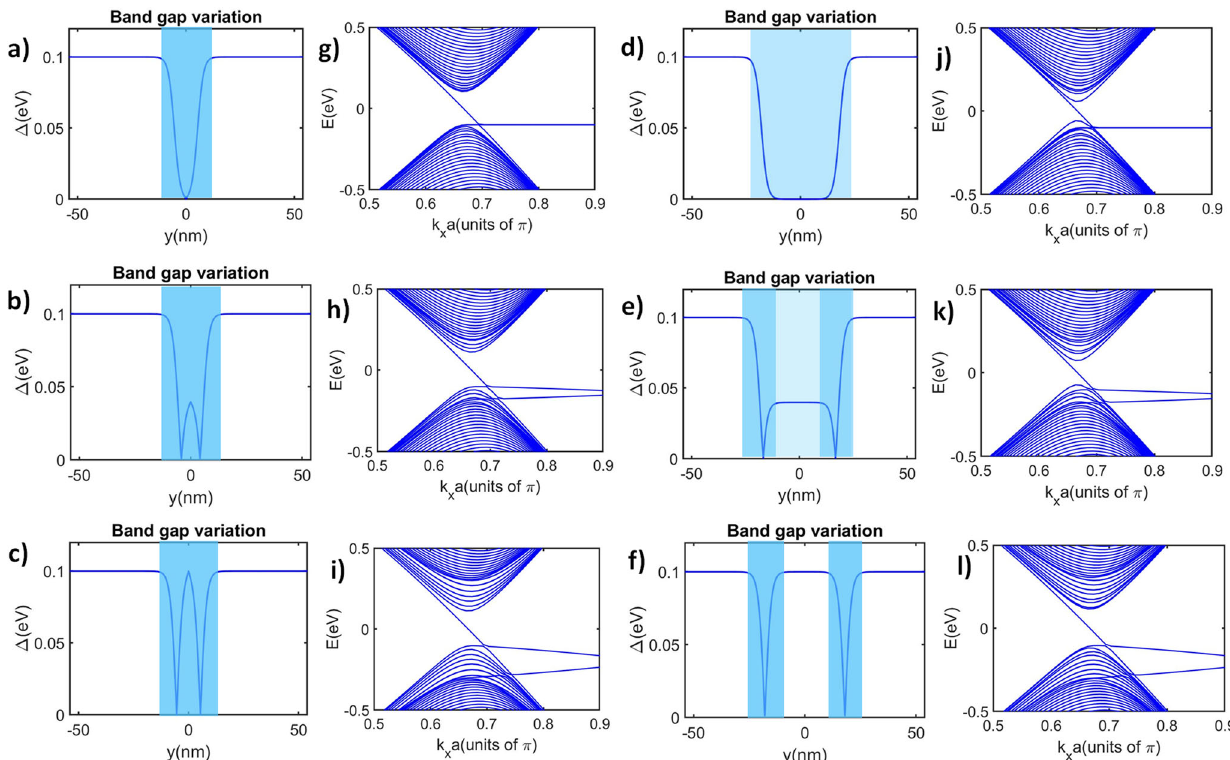
Fig. 4 Spatial variation of local band gap and electronic band structure for different cases of λ SO and W j considered. a , g W j = 6.25 nm and = 0 eV. b , h W = 6.25 nm and λ λ SO j 0.04 eV. f , l W j = 20.8 nm and λ SO = 0.1